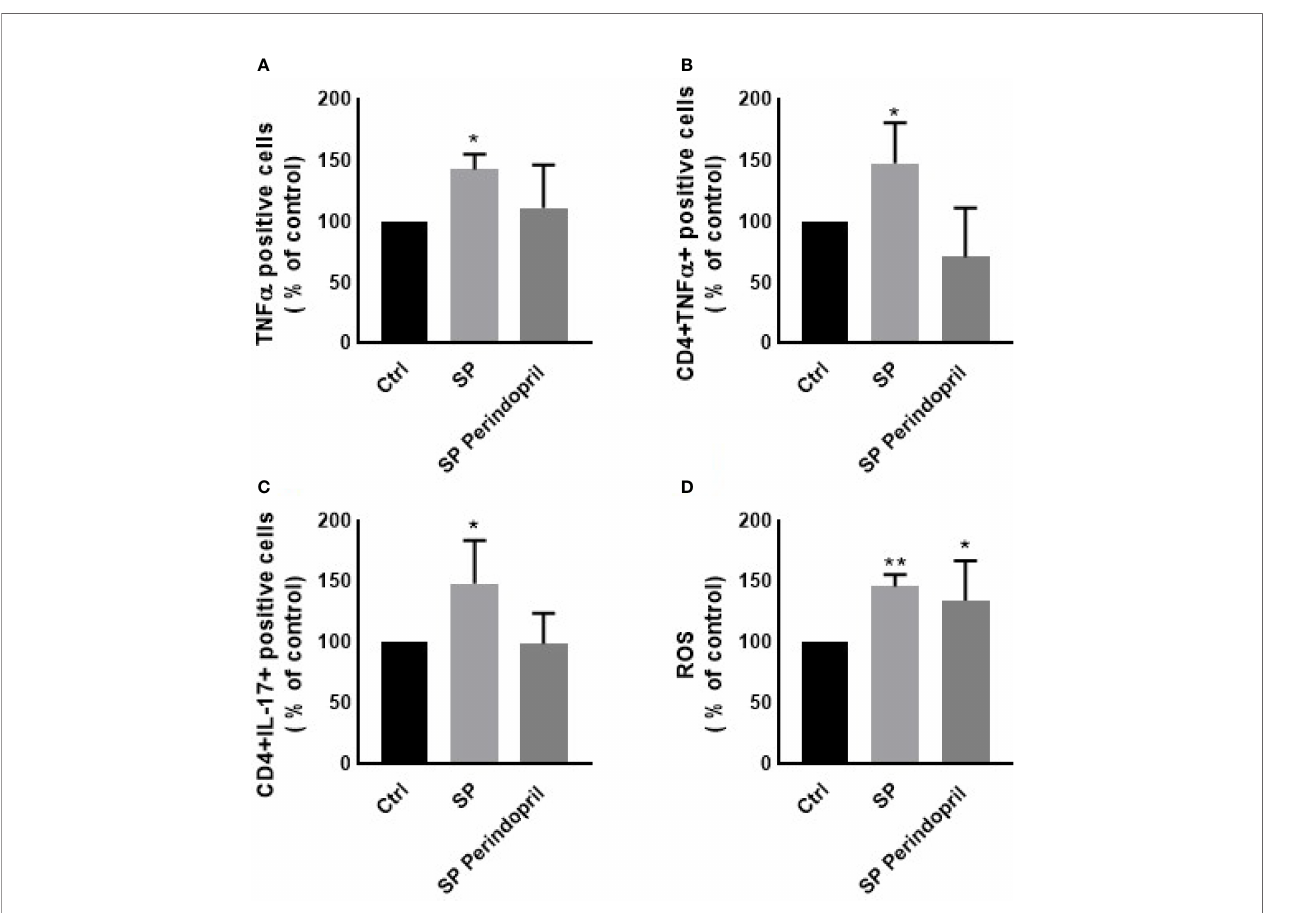
FIGURE 3 | Effects of spike (S) protein stimulation on PBMCs. PBMCs were mock treated controls (Ctrl), stimulated with S protein (SP) (100 µM), or SP with ACE inhibitor (SP Perindopril, 100 µM), perindopril, added 2 h before SP. Flow cytometry analysis was performed for measurement of (A) expression of TNF a in PBMCs, (B) expression of TNF a on CD4 positive T cells, (C) expression of intracellular IL-17 on CD4 T cells, and (D) ROS production on PBMCs. The data are presented as mean ± SEM, n = 4. Ordinary one-way ANOVA followed by Dunnett ’ s test: * p < 0.05, ** p <